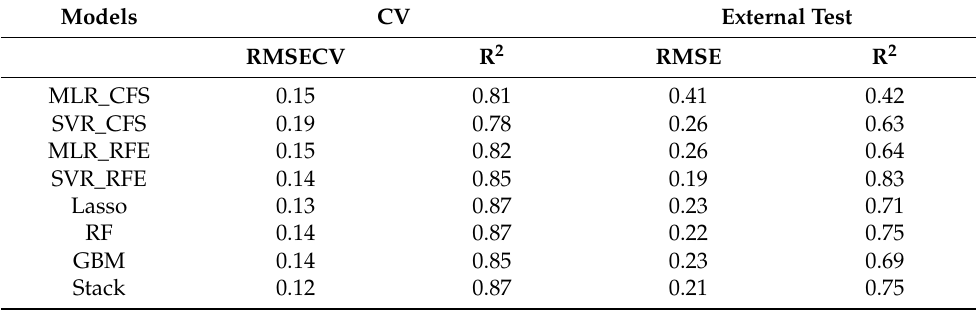
Table 3. Prediction performances of all models at pH 5.0.